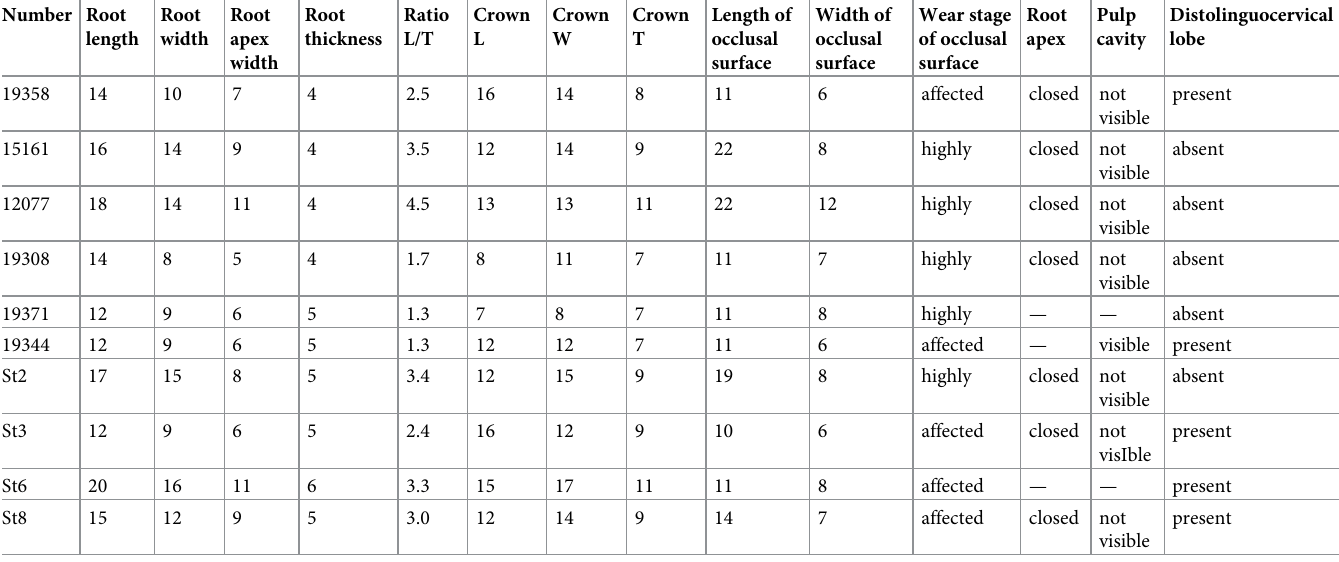
Abbreviations: L = length; W = width; T =